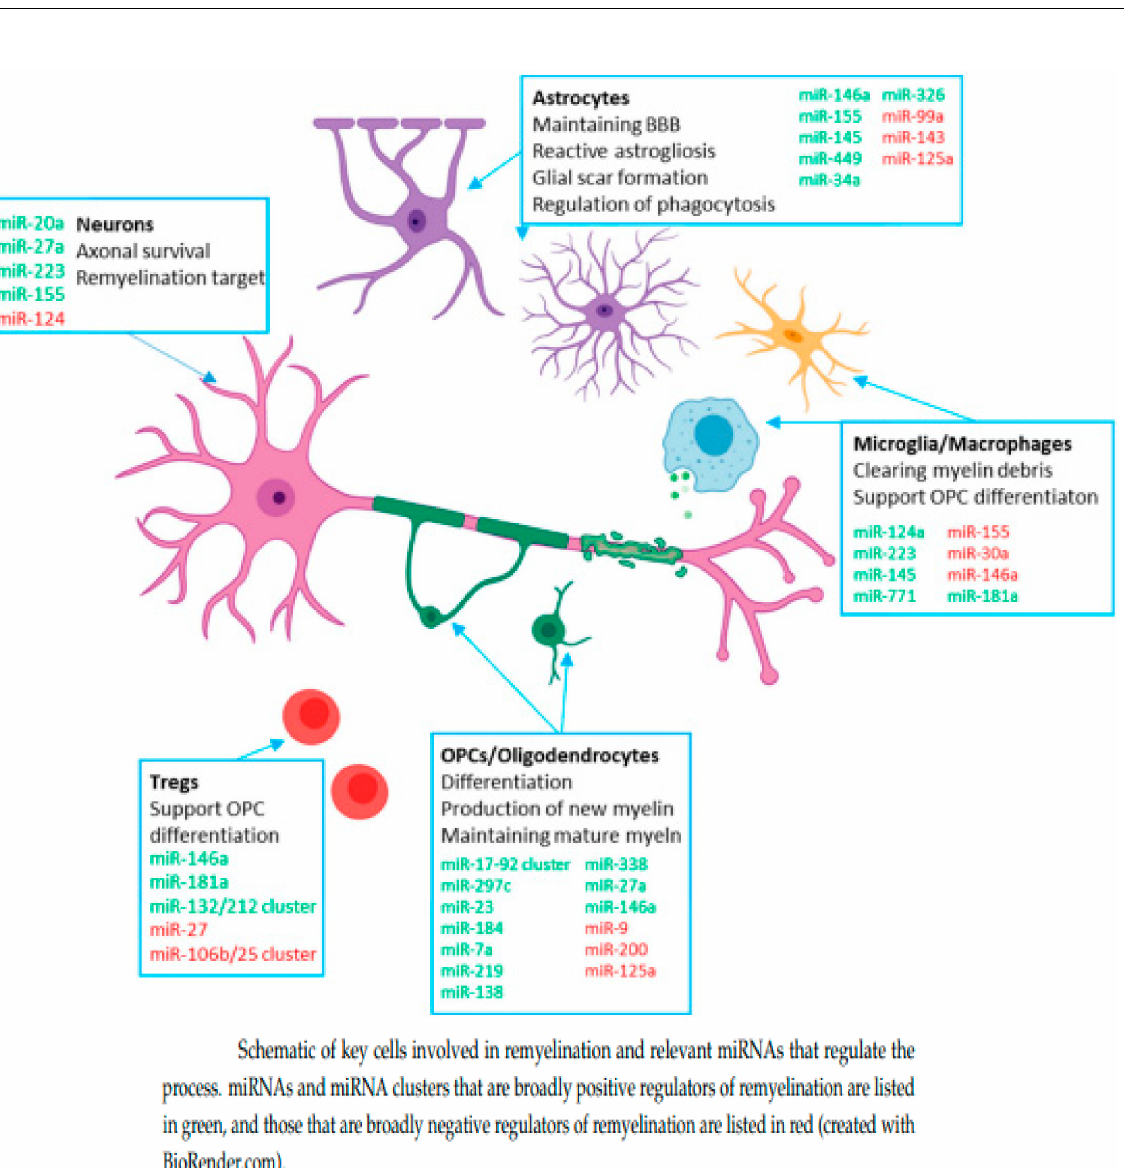
Figure 4. Key Cells involved in Remyelination and relevant miRNAs